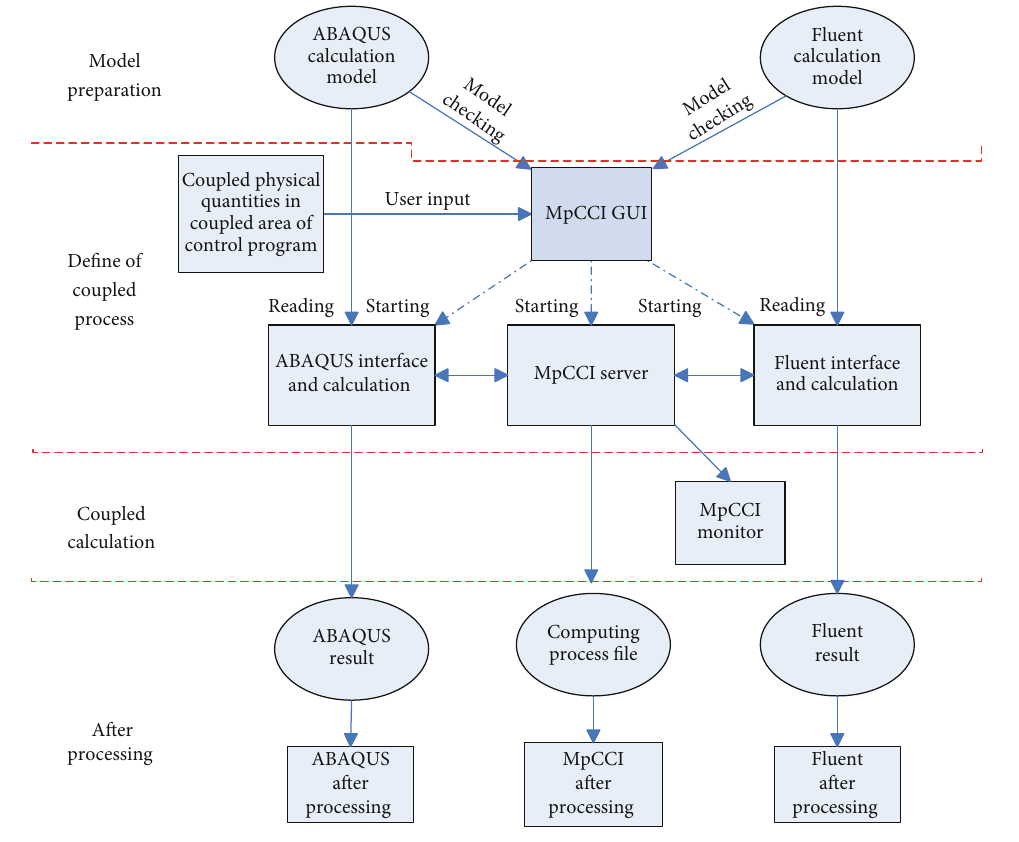
Figure 2: Coupled calculation process.